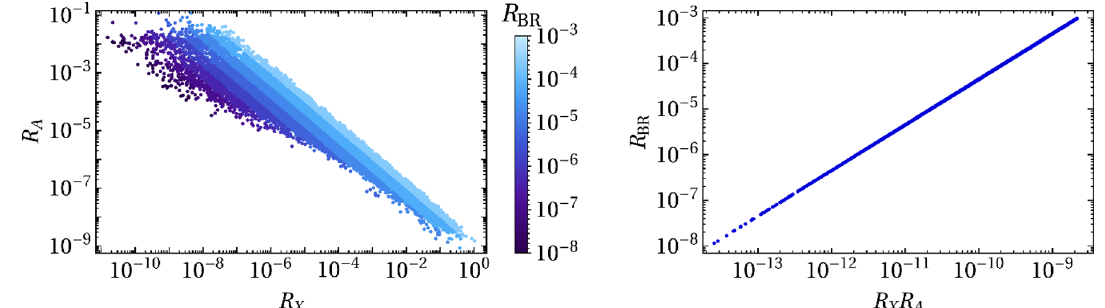
Figure 6 . Scatter plots of R A vs. R X (left panel) and of their product R X R A vs. R BR (right panel) for the blue points of figure 4. The definitions of R A , R X , and R BR are given in (3.6) and (3.7). X (tree)